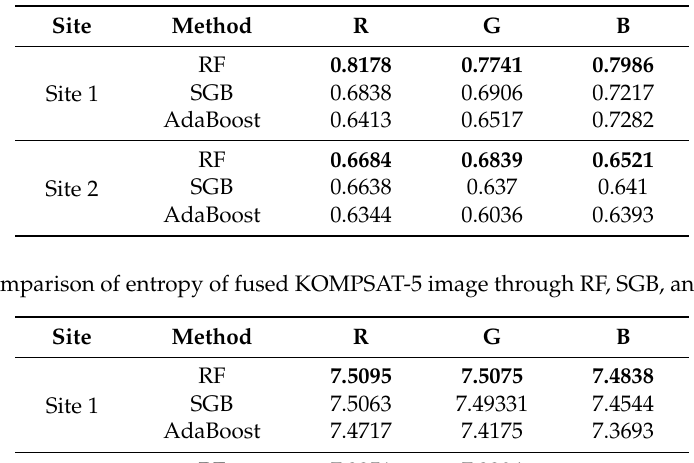
Table 7. Comparison of CC of fused KOMPSAT-5 image through RF, SGB, and AdaBoost.